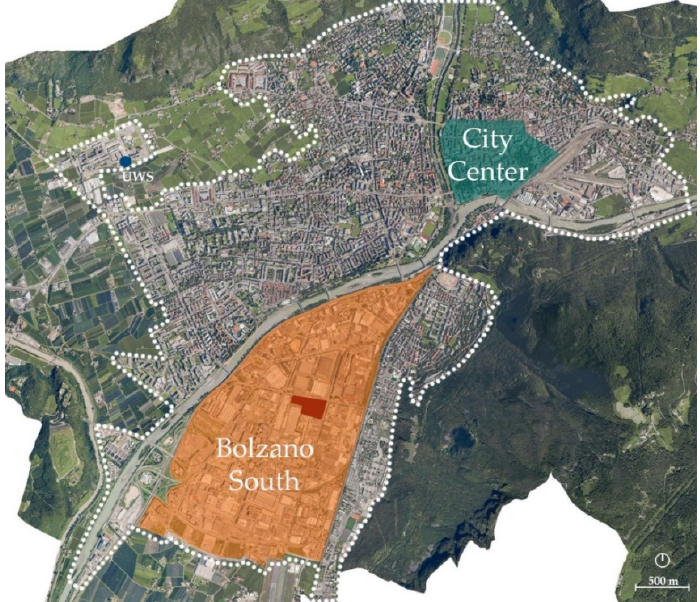
Figure 1 . Aerial view of Bolzano highlighting the city center (green), the Bolzano South industrial area (orange), and the NOI Techpark (red). The blue dot indicates the location of the UWS. Aerial image source: [39].